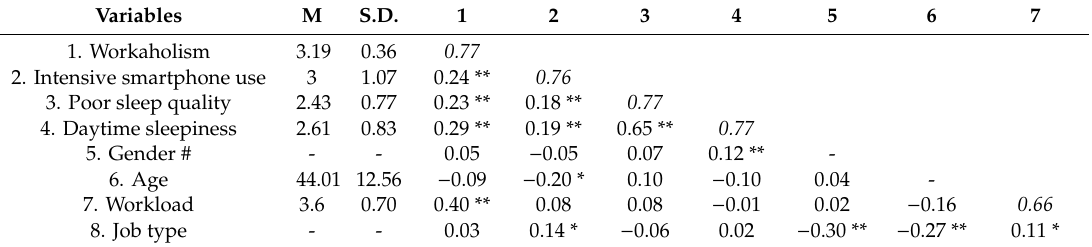
Table 1. Descriptives, reliabilities (Cronbach’s Alphas in italic in diagonal) and inter-correlations of the focused